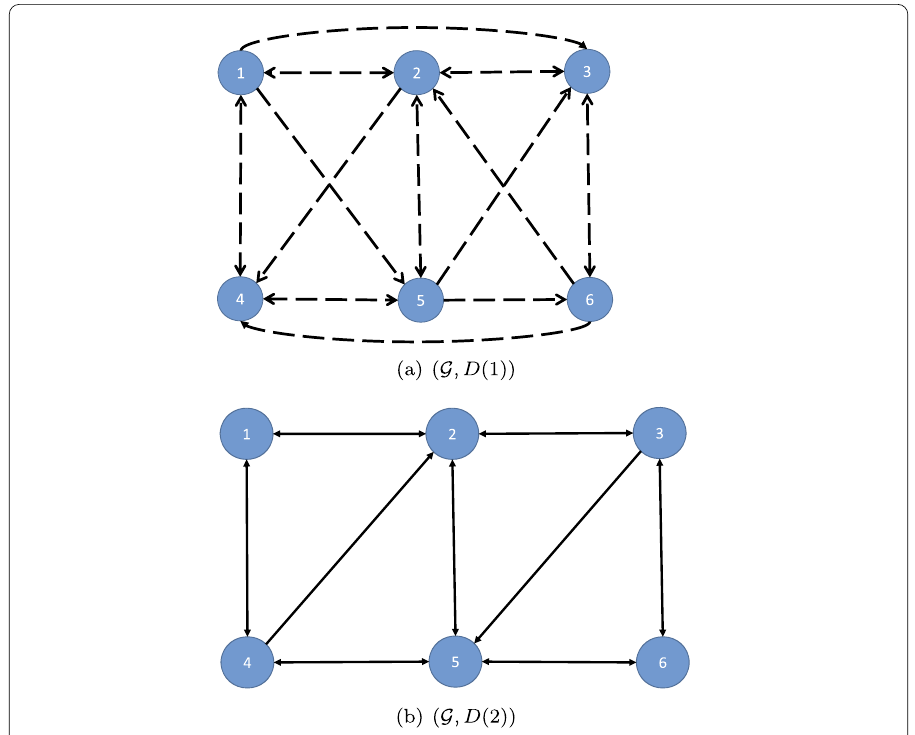
Figure 2 The diagram for two diagraphs ( G , D (1)) and ( G , D (2))